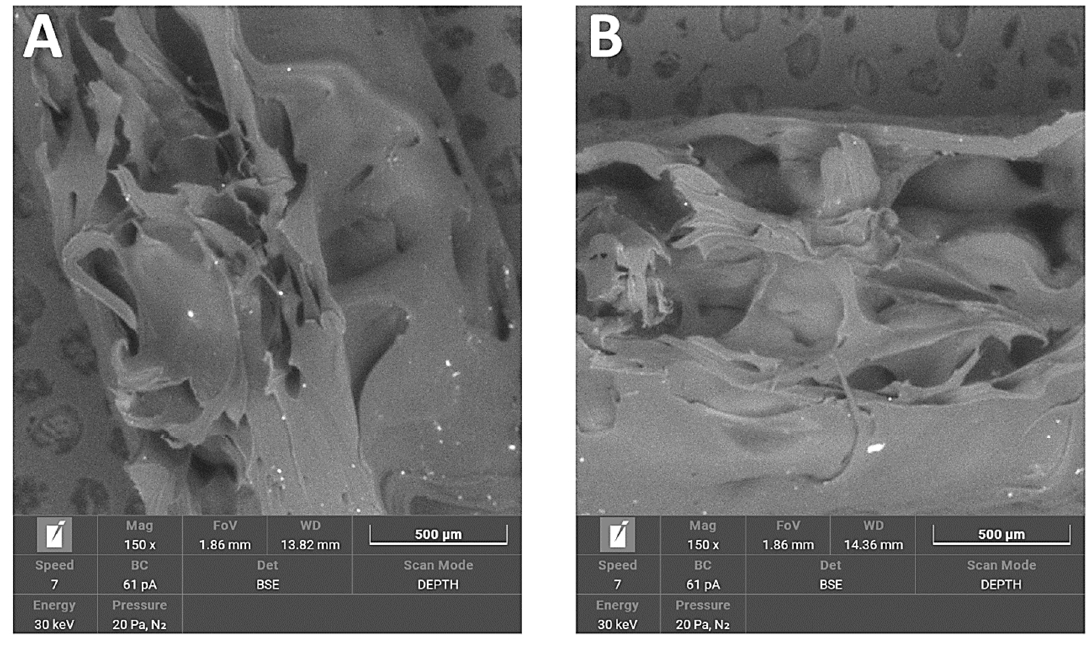
Figure 12. SEM micrographs used to compare breakthroughs of ( A ) PA12_NS and ( B ) PA12_S